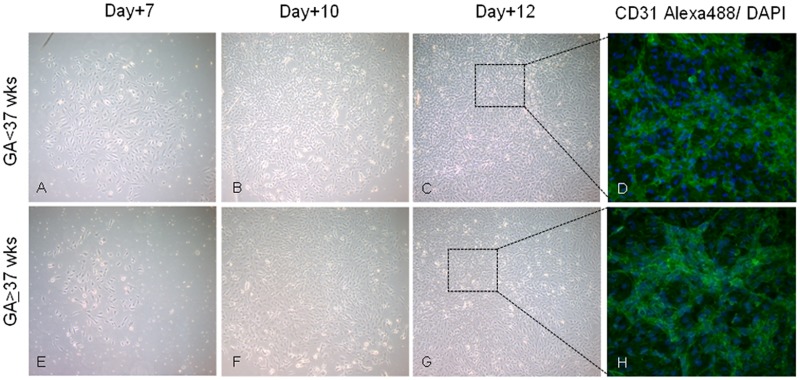
Endothelial Colony Forming Cell (ECFC) in pre-term and term- umbilical cord blood.Representative photomicrographs of ECFCs from mononuclear cells isolated from pre-term (GA<37 wks, A-C) and term (GA≥37 wks, E-G) cord blood at different time of culture (Original magnification 50X). (D,H) Immunofluorescence staining of CD31 (green) and DAPI (blue) (Original magnification 200X).